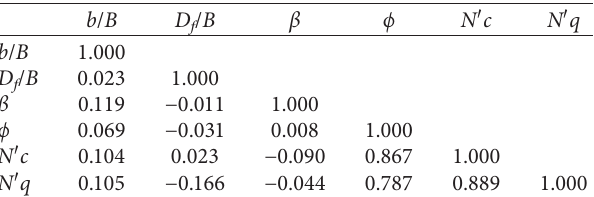
Table 3: Pearson correlation